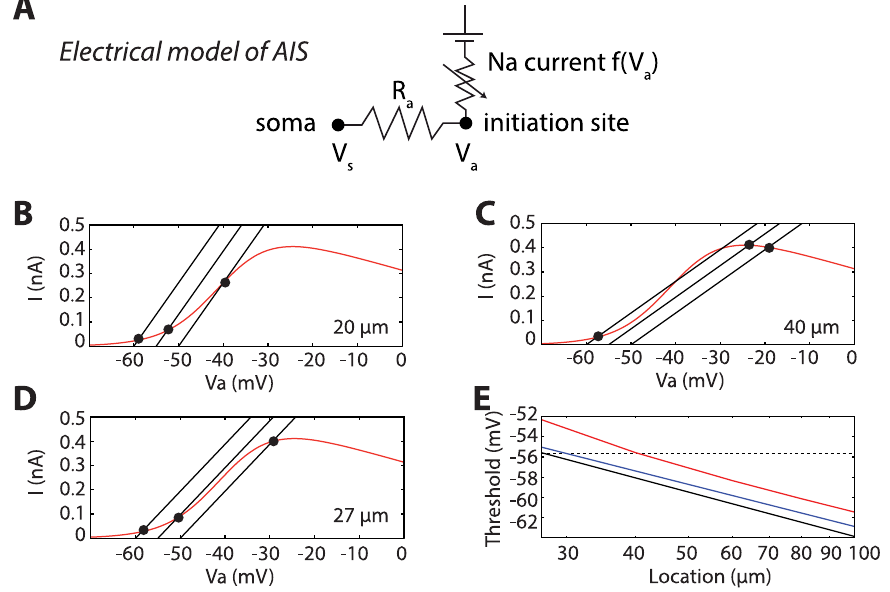
Figure 2. Spike initiation sharpness due to a bifurcation. A, Simplified electrical model of the axon initial segment (used for theoretical analysis but not for simulations). The initiation site is coupled to the soma through an axial resistance Ra. Sodium current f(V a ) equals axial current (V a 2 V s )/R a . B, Sodium current (red) and lateral current (black) as a function of voltage at the initiation site when Na channels are placed at 20 m m away from the soma. The three lines correspond to somatic voltages of 2 60 mV, 2 55 mV and 2 50 mV. C, Same as B, with Na channels at 40 m m from the soma. D, Same as A at the critical point, with channels at 27 m m away from the soma. E, Predicted somatic spike threshold, defined as the bifurcation point, as a function of location of the initiation site (logarithmic scale) for the full formula (black) and its approximation (blue). The red curve shows the somatic voltage at which half of the sodium channels are activated in the numerical simulation of the ball-and-stick model. The dashed line is the predicted spike threshold at the critical point.